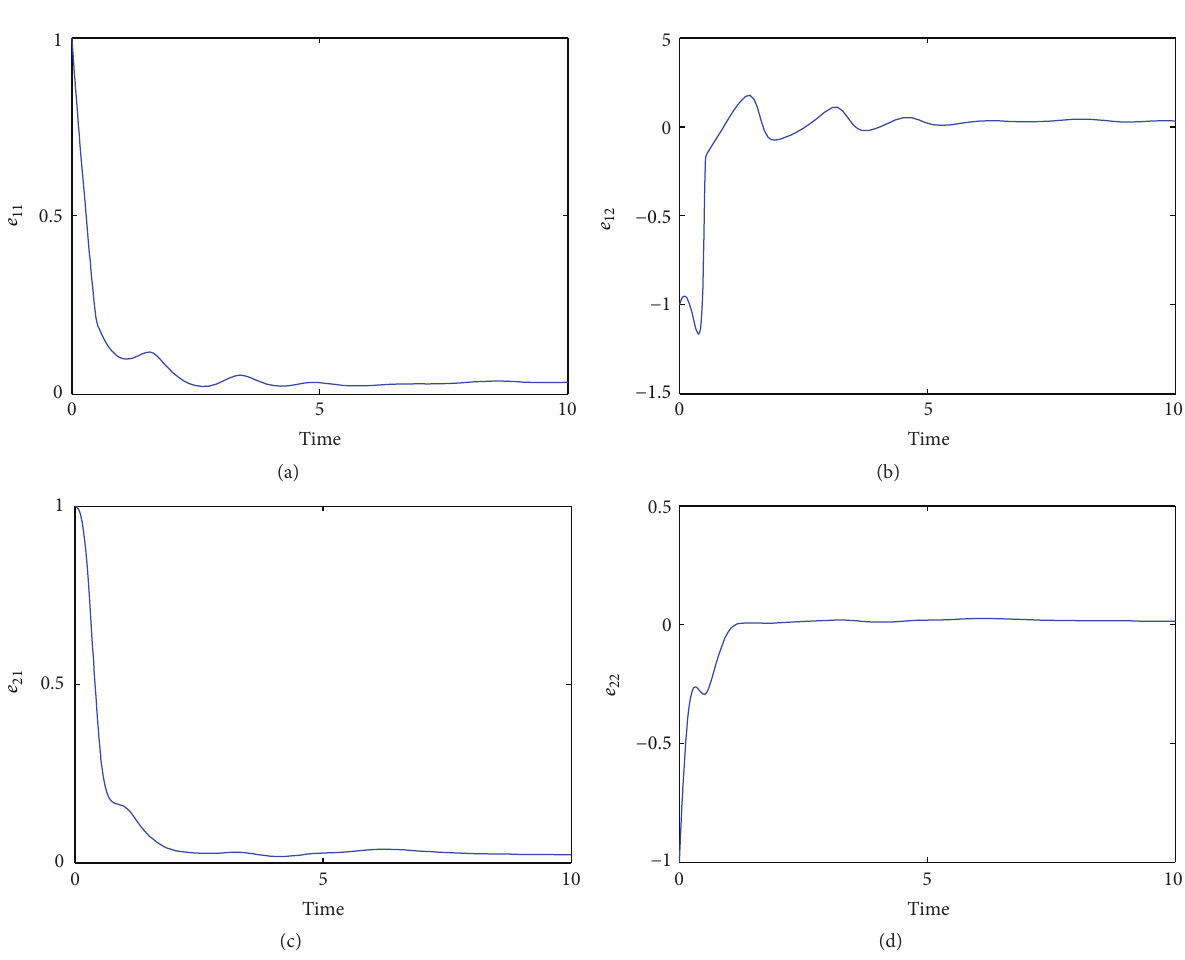
Figure 2: Simulation results of the estimation errors with 𝛽 ∗ 11 = 0.8 , 𝛽 ∗ 12 = 1 , 𝛽 ∗ 21 = 1.2 , and 𝛽 ∗ 22 = 1.4 .